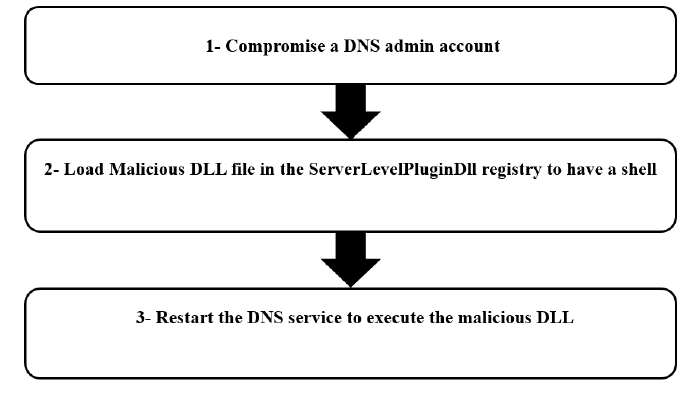
Figure 5. DNS Admins’ Privileges Escalation